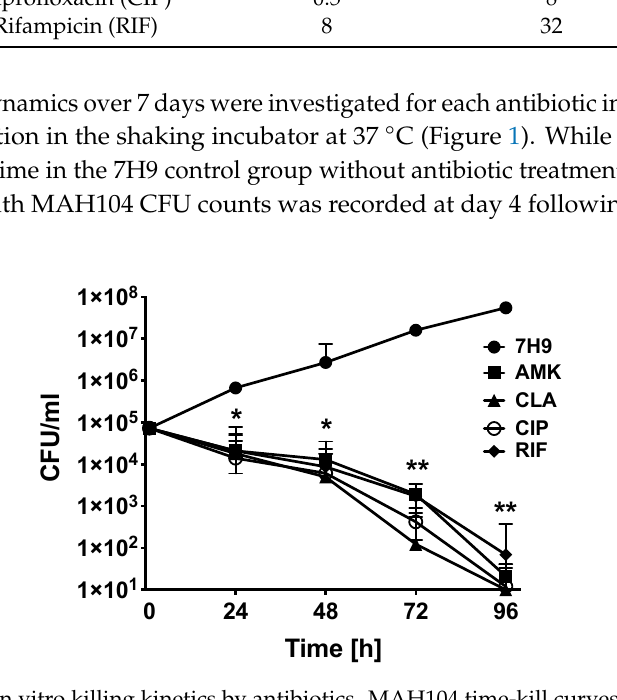
Figure 1. MAH104 in vitro killing kinetics by antibiotics. MAH104 time-kill curves using bactericidal concentrations of AMK, CLA, CIP, and RIF demonstrate viable bacterial colony forming units over 4 days. Antibiotics were added to bacterial cultures in 7H9 broth at time zero, and drug treatment groups were compared to MAH104 growth control. Data represent the means ± standard deviations (SD) obtained from three independent experiments. Unpaired two tailed t -test was performed. * p < 0.05 and ** p < 0.01 statistically significance between antibiotic treatment and control groups.